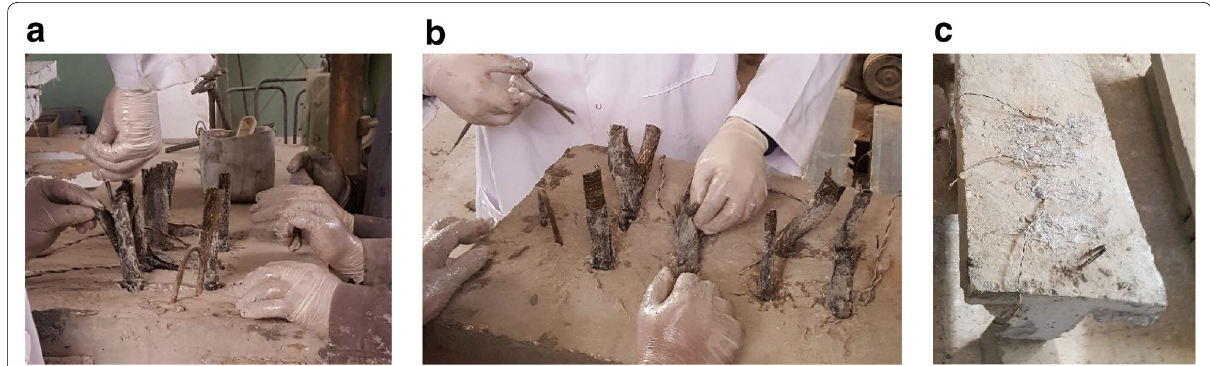
Fig. 7 Fabrication process to form a closed BFRP stirrup: a the fiber sheets were cut into strips similar to a fan shape; b the strips were impregnated with epoxy and overlapped around the cross section, and c the groove was filled with epoxy adhesive, and the surface was leveled.